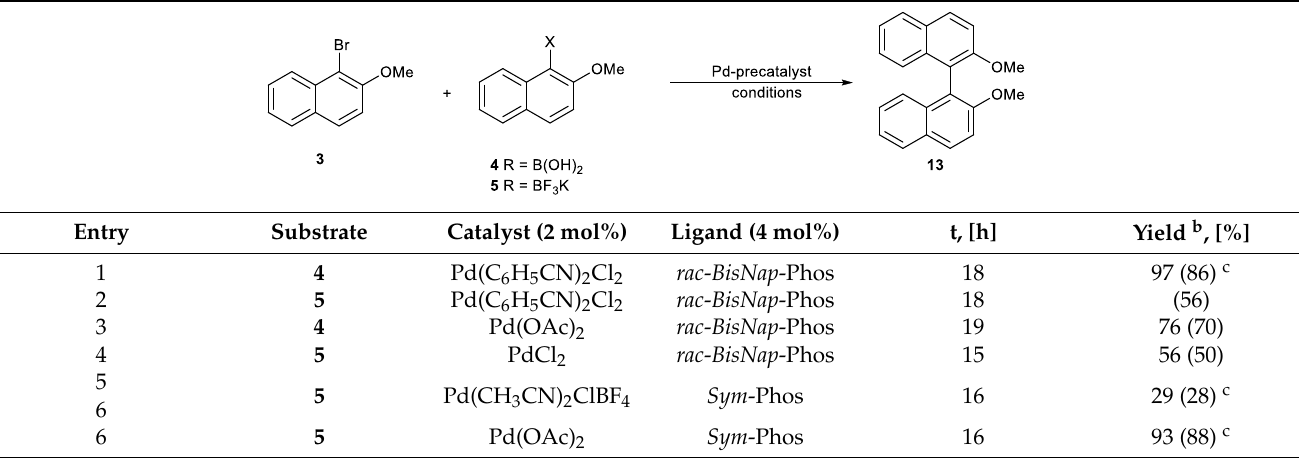
Table 2. Effect of the precatalyst used in the synthesis of 13 a .